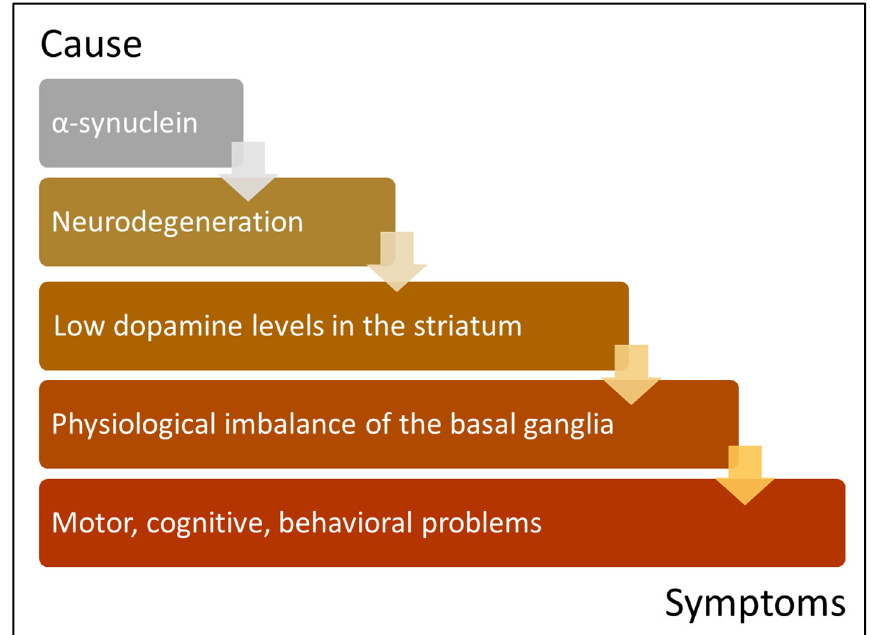
Figure 2. Hierarchy of Parkinson’s disease pathogenesis. This figure illustrates the multiple levels where gene therapy is capable of intervention in the treatment of Parkinson’s disease. From bottom upwards: the motor and non-motor symptoms of Parkinson’s disease are caused by the over-activity of the subthalamic nucleus in the basal ganglia due to a reduction in dopamine levels caused by the death of dopaminergic neurons. This cascade of events is thought to be triggered by the α -synuclein pathology in those neurons. Left: examples of gene therapy trials discussed in this review (GAD, AADC, TH, GDNF, RNAi); and right: examples of current therapeutic strategies aimed at each level).